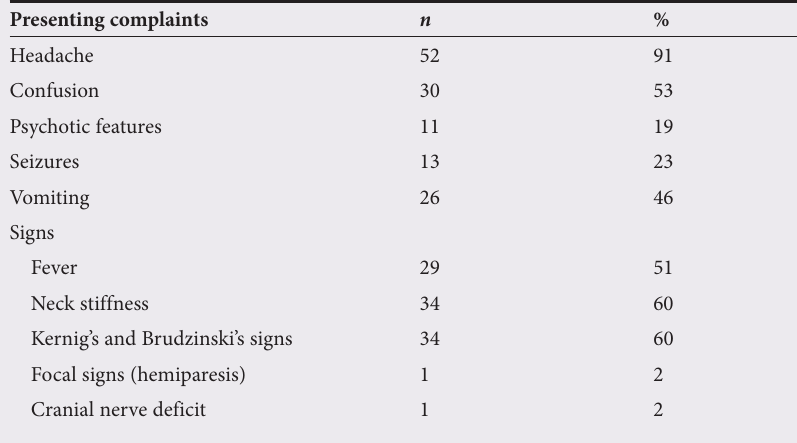
Table 1. Presenting symptoms and signs of patients admitted with cryptococcal meningitis ( N